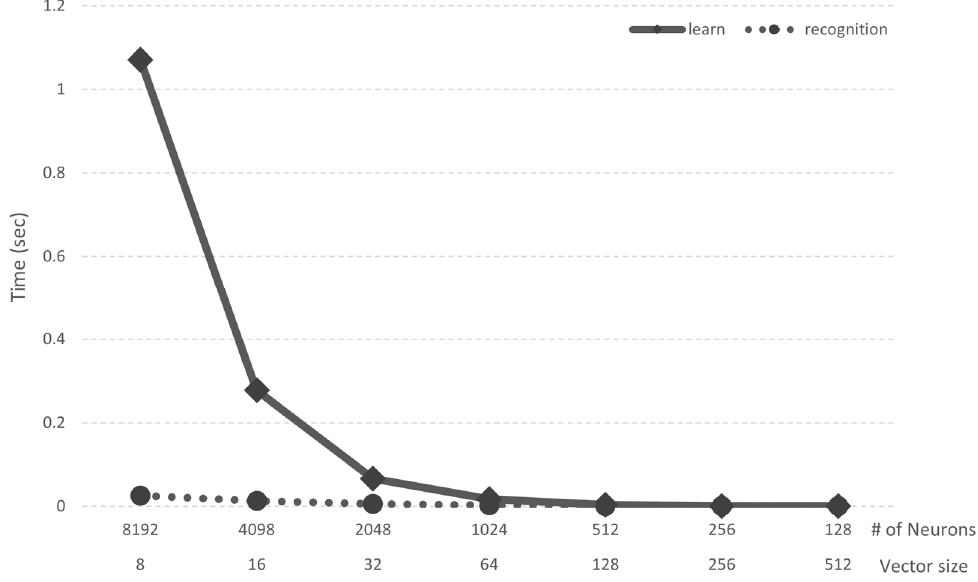
Figure 11. Time consumption of training and recognition .